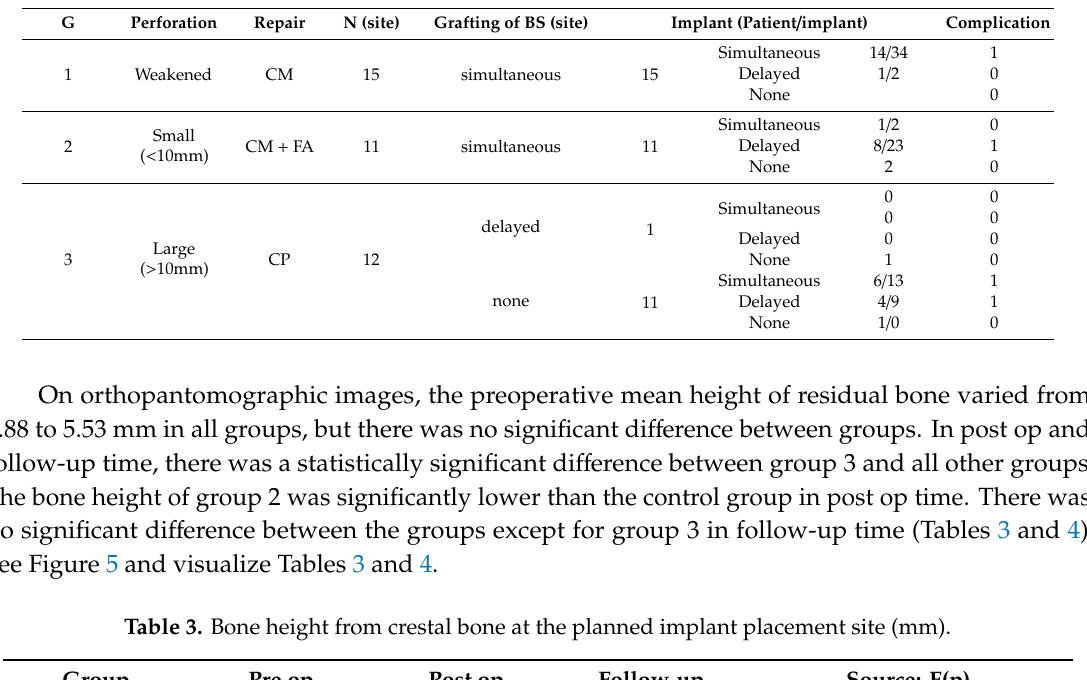
Table 2. Summary regarding progress of repair according to perforation size. (All complications were periimplantitis during follow-up period. Abbreviations; CM: Collagen membrane, FA: Fibrin adhesive, CP: Collagen plug, G: Group, BS: Bone substitute).